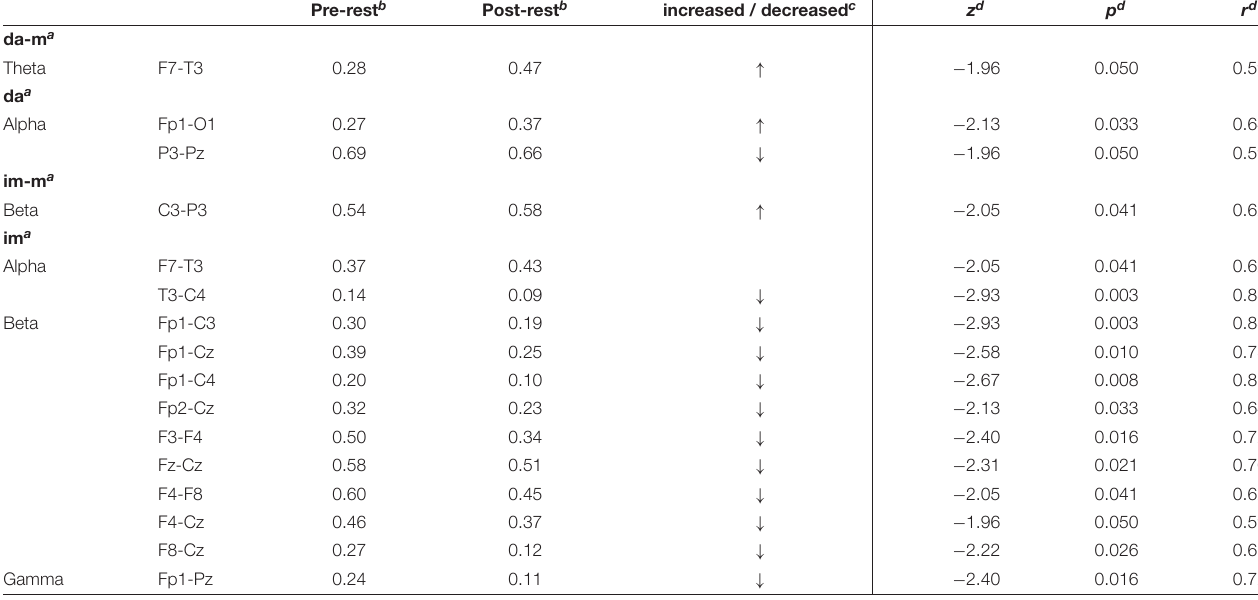
TABLE 3 | Significant time effects for electrode pairs of both connectivity analysis (COH and ICOH).